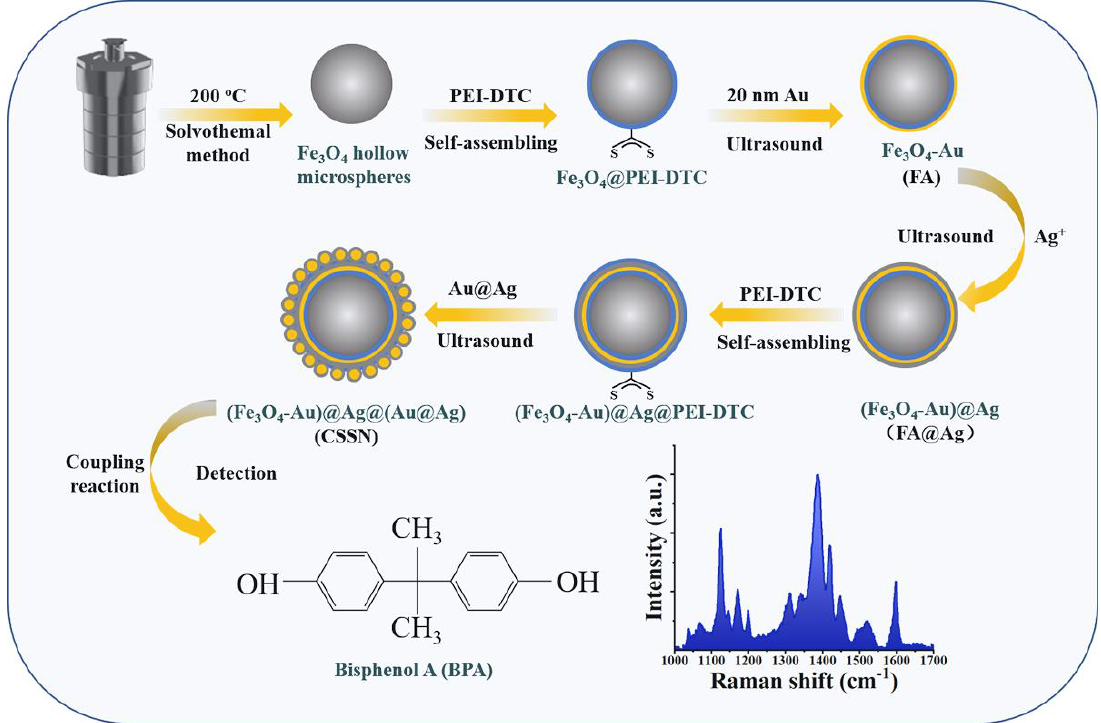
Scheme 1. Scheme of synthetic process of CSSN NCs and SERRS detection protocol for BPA on CSSN SERRS substrates.